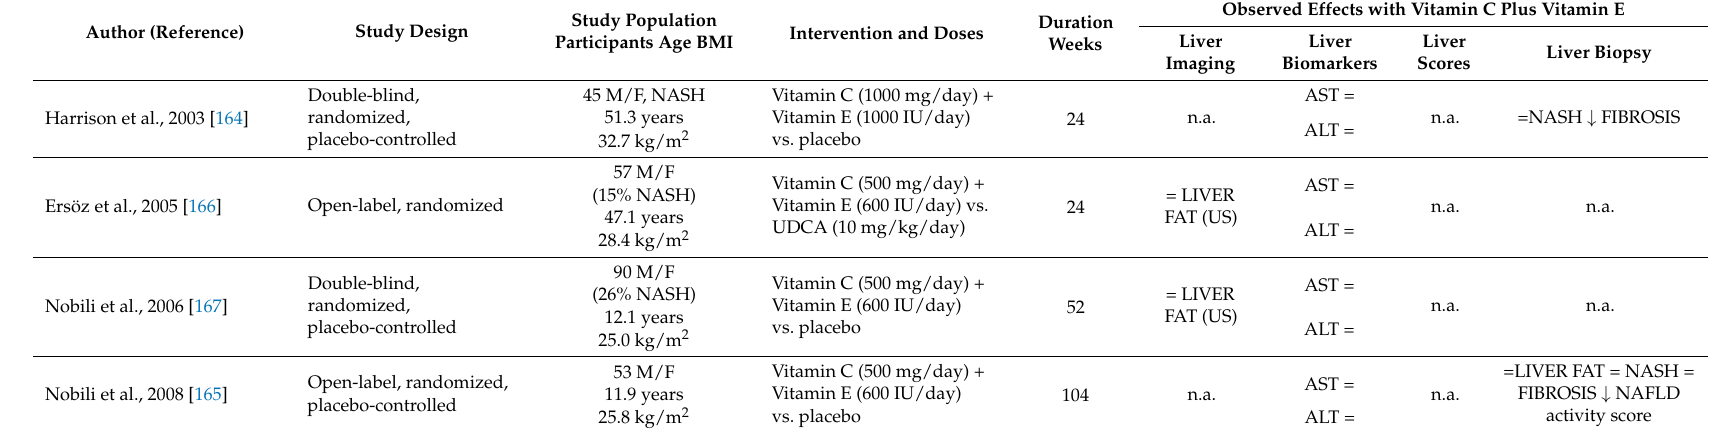
Table 5. Clinical trials on the supplementation of vitamins C + E on NAFLD in individuals at high cardiometabolic risk.